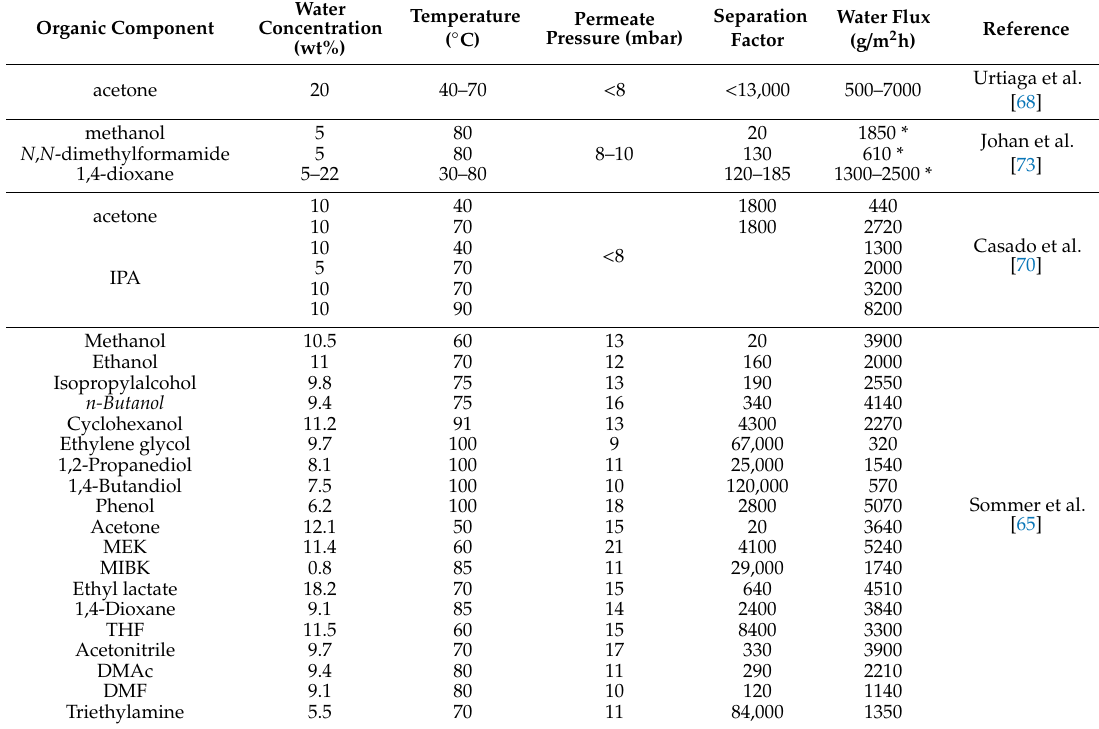
Table 5. Pervaporation performance for various solvents in their aqueous solutions, separation achieved using the commercial silica membrane, PVP (Pervatech